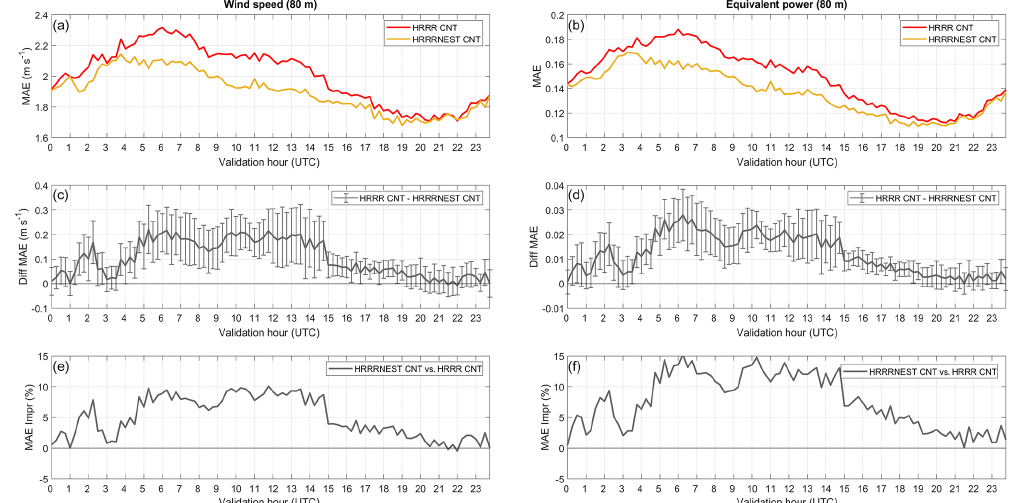
Figure 6. As in Fig. 5 but for HRRRNEST CNT (in yellow) vs. HRRR CNT (in red) runs, showing the impact on 80m wind speed MAE of finer model horizontal grid